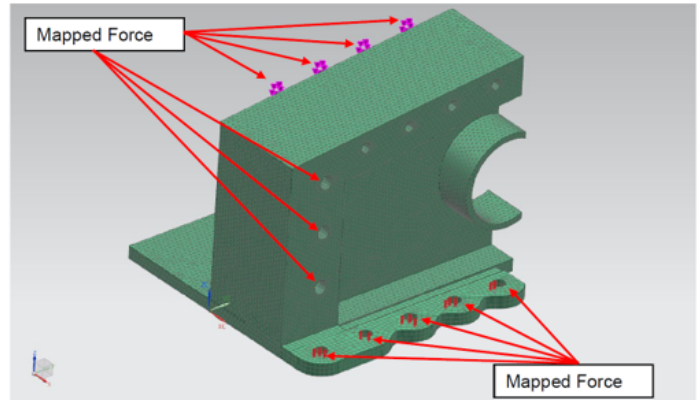
Figure 11. Mapped loading on the wing root model.